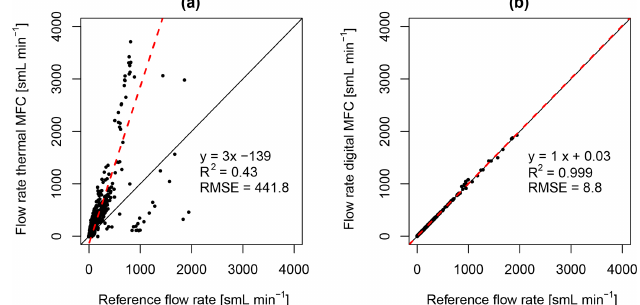
Figure 10. Regression of (a) the thermal mass flow controller flow rate versus the reference flow rate and (b) the digital mass flow con- troller flow rate with errors versus the reference flow rate. The ref- erence flow rate was varied at a frequency of 10Hz proportional to measured vertical wind velocity data. The black solid line denotes the 1 : 1 line, and the dashed red line denotes the linear model